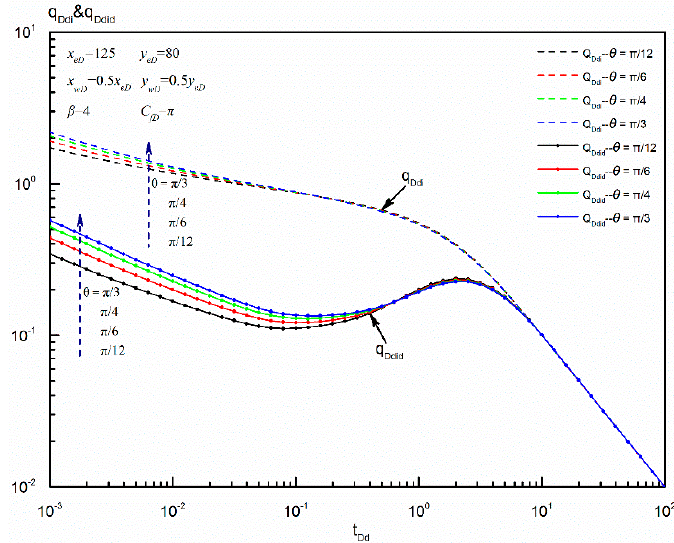
Figure 13. Blasingame format curves for a fractured well in an anisotropic rectangular reservoir at different values of azimuth angle.